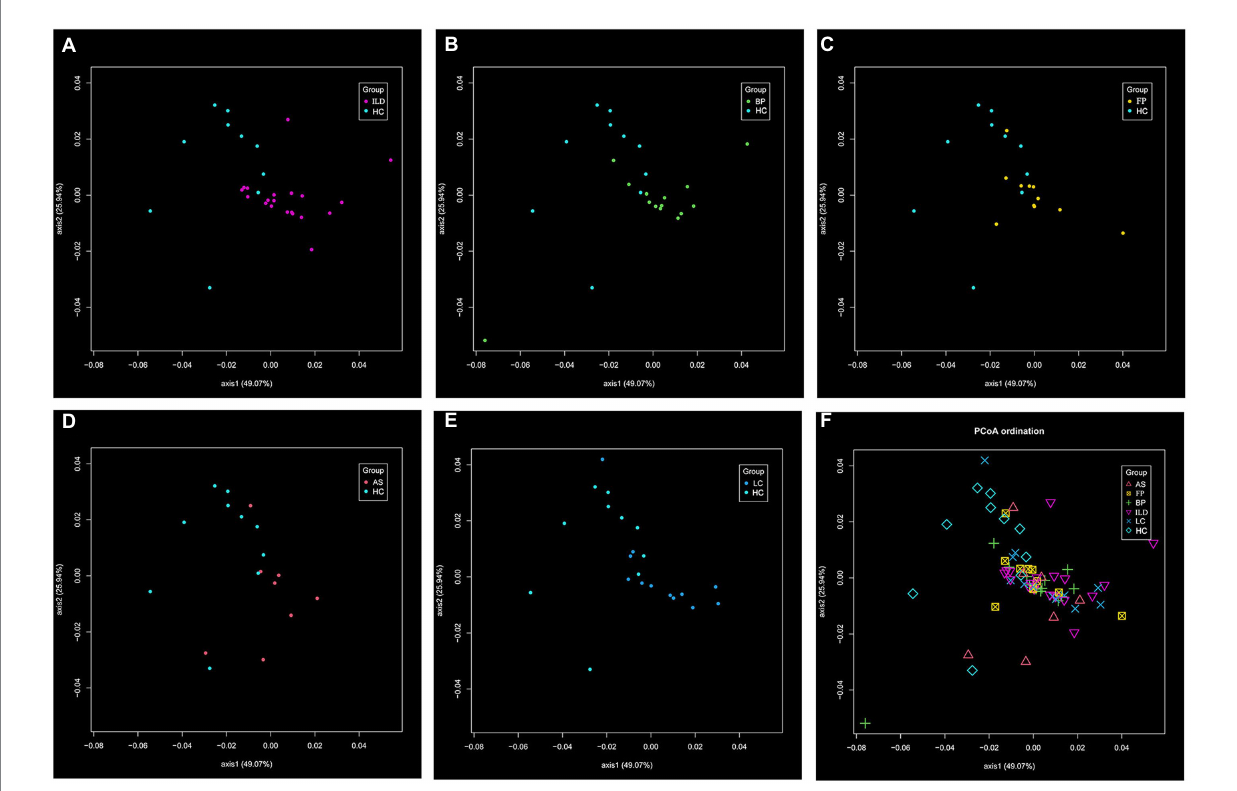
FIGURE 4 The β -diversity of the identified OTUs. The distance matrix was calculated using the altGower index. The significant difference was calculated with PERMANOVA analysis, and suggested by P adj value. The comparison of (A) ILD vs. HC; (B) BP vs. HC; (C) FP vs. HC; (D) AS vs. HC; (E) LC vs. HC ( P adj < 0.05); (F) among the six groups (significant difference existed between BP and LC, P adj < 0.05).